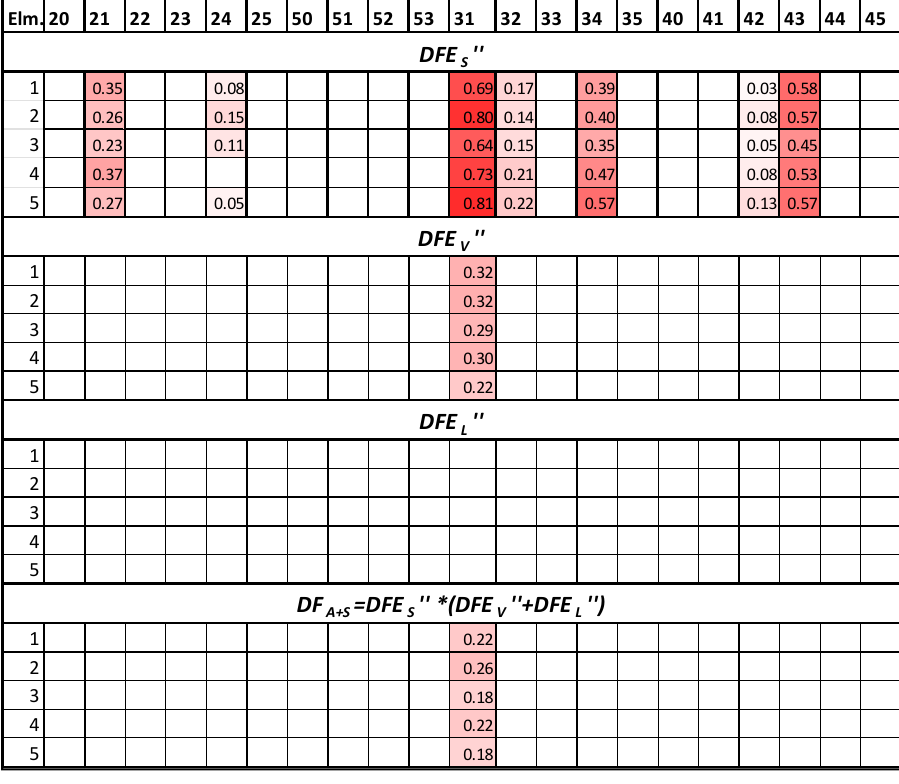
Figure 9. Identified damage using the proposed framework for damage case 1(b).